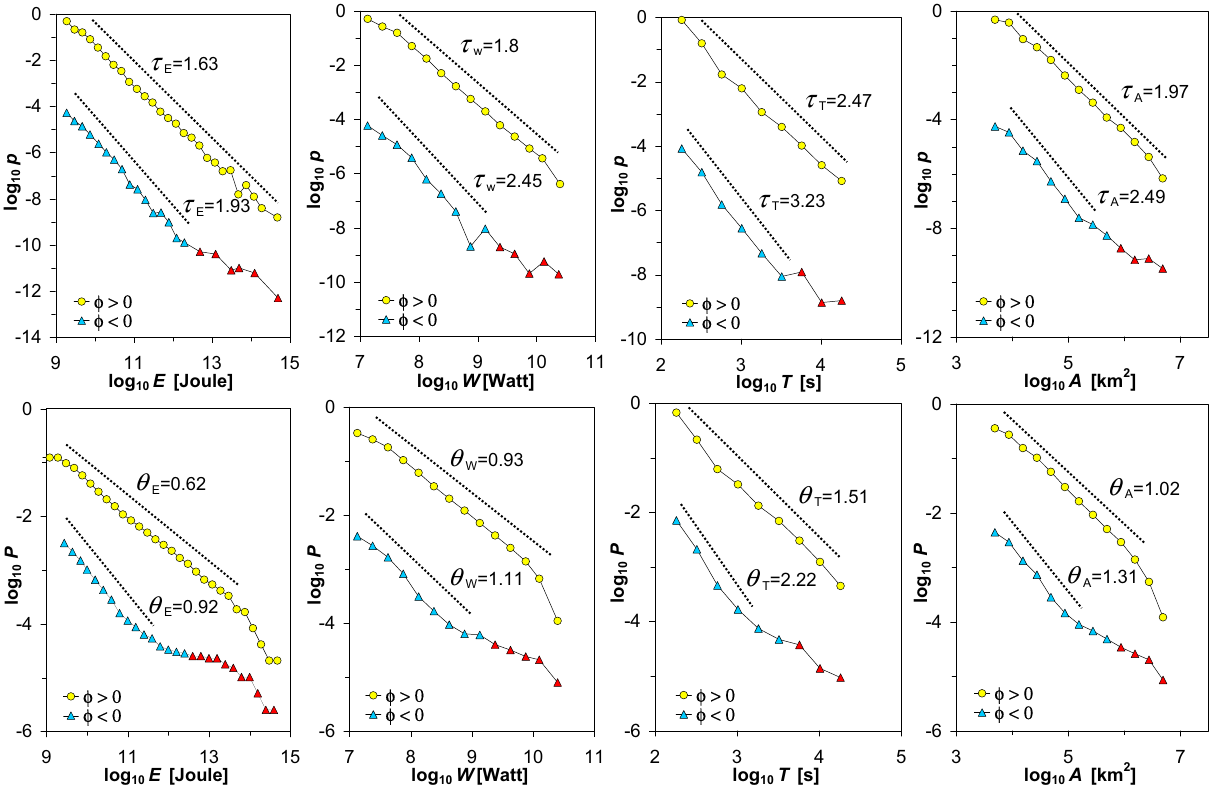
Fig. 3. Probability density (top row) and cumulative (bottom row) distributions of emission energy E , peak emission power W , emission lifetime T , and peak emission area A , constructed for precipitation events which initiated above and below the φ = 0 boundary. Low-latitude distributions are shifted downward for easier comparison. The plots reveal three distinct modes of ionospheric unloading described by significantly different distribution slopes: small-scale ( A 1 mode) and large-scale (mode A 2 ) events started at φ< 0, as well as the events which started at φ> 0 irrespective of their size ( B mode). The dotted lines show linear regression slopes for A 1 and B emission modes. Note the absence of distribution crossovers for the high-latitude